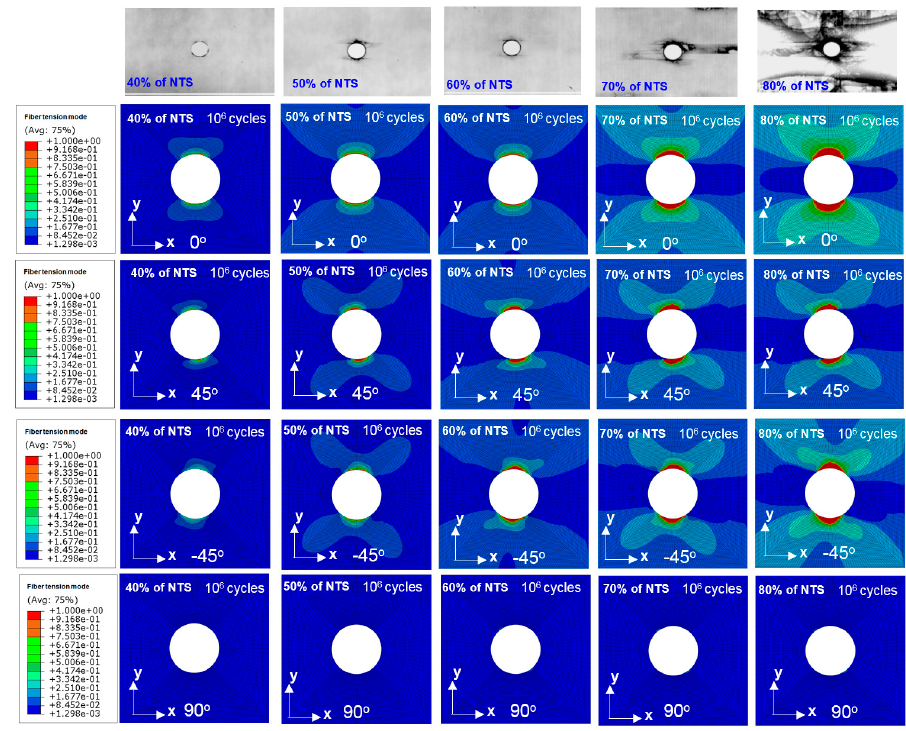
Figure 10. Fiber tension failure index after 10 6 cycles in the quasi-isotropic Open Hole Tension (OHT) specimen. J. Compos. Sci. 2018 , 2 , x FOR PEER REVIEW